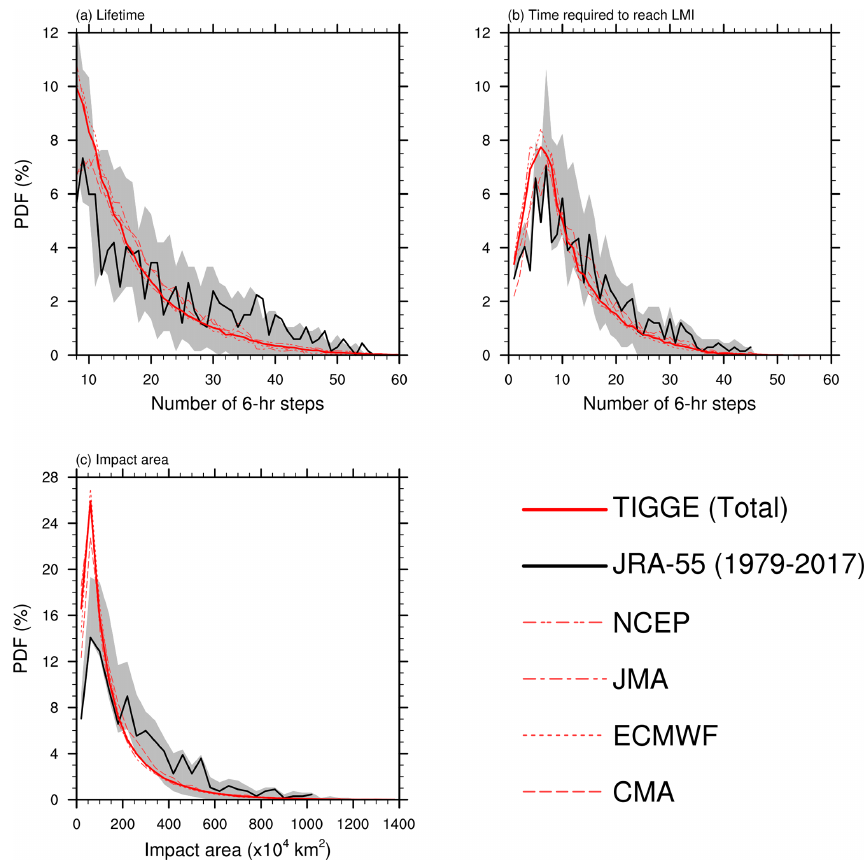
Figure 7. The distribution of (a) lifetime, (b) time required to reach LMI, and (c) impact area of TCs in the TPEPS TC event set (red lines) and the JRA-55 event set (black line). The grey area indicates the spread of the lifetime distribution of JRA-55 if finite simulation windows are applied to the JRA-55 event